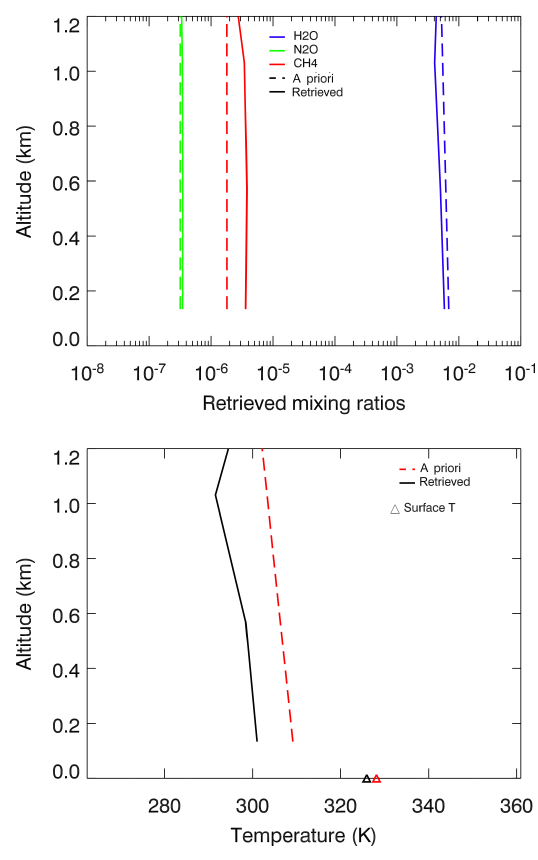
Figure 2. A priori (dash or red) and retrieved (solid or black) atmo- spheric states (H 2 O, N 2 O, CH 4 , temperature, and surface tempera-